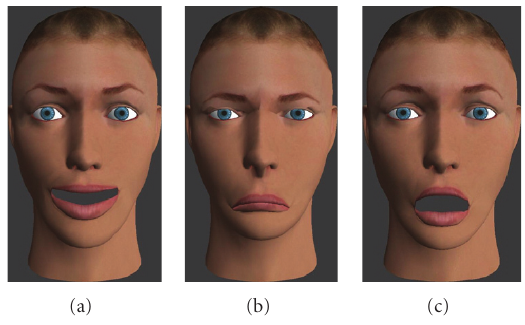
Figure 5: Group-1 images. From left to right: Stories 1, 2, and 3.